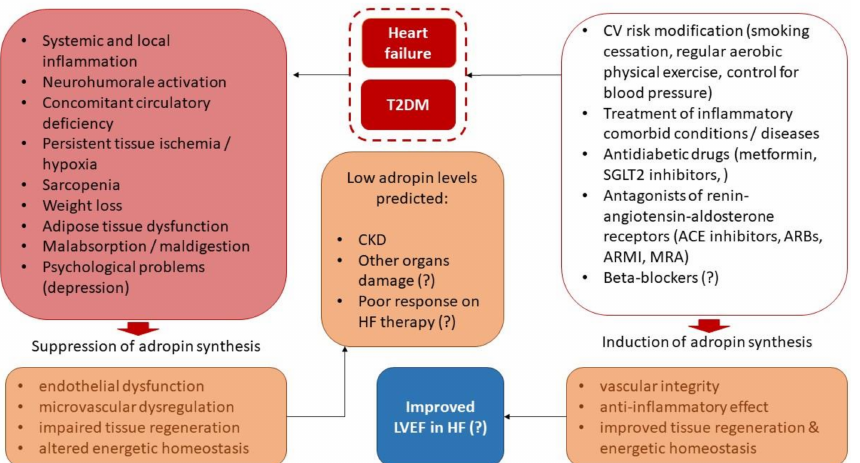
Figure 4. The plausible diagnostic and predictive values of adropin in patients with HF and con- comitant T2DM. Abbreviations: ARBs, angiotensin-II receptor blockers; ARNI, angiotensin receptor neprilysin inhibitor; HF, heart failure; ACE, angiotensin-converting enzyme; CKD, chronic kidney disease; LVEF, left ventricular ejection fraction; SGLT2, sodium-glucose co-transporter 2; T2DM, type 2 diabetes mellitus; ?, no strong